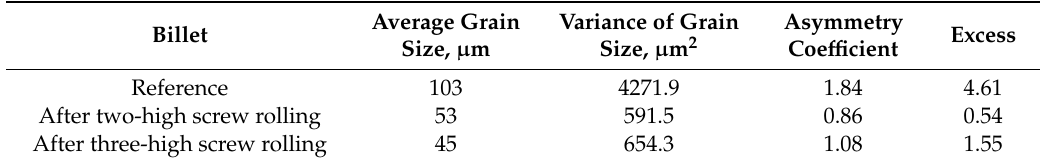
Table 1. Characteristics of the grain size distribution for the reference billet and the billets after two- and three-high screw